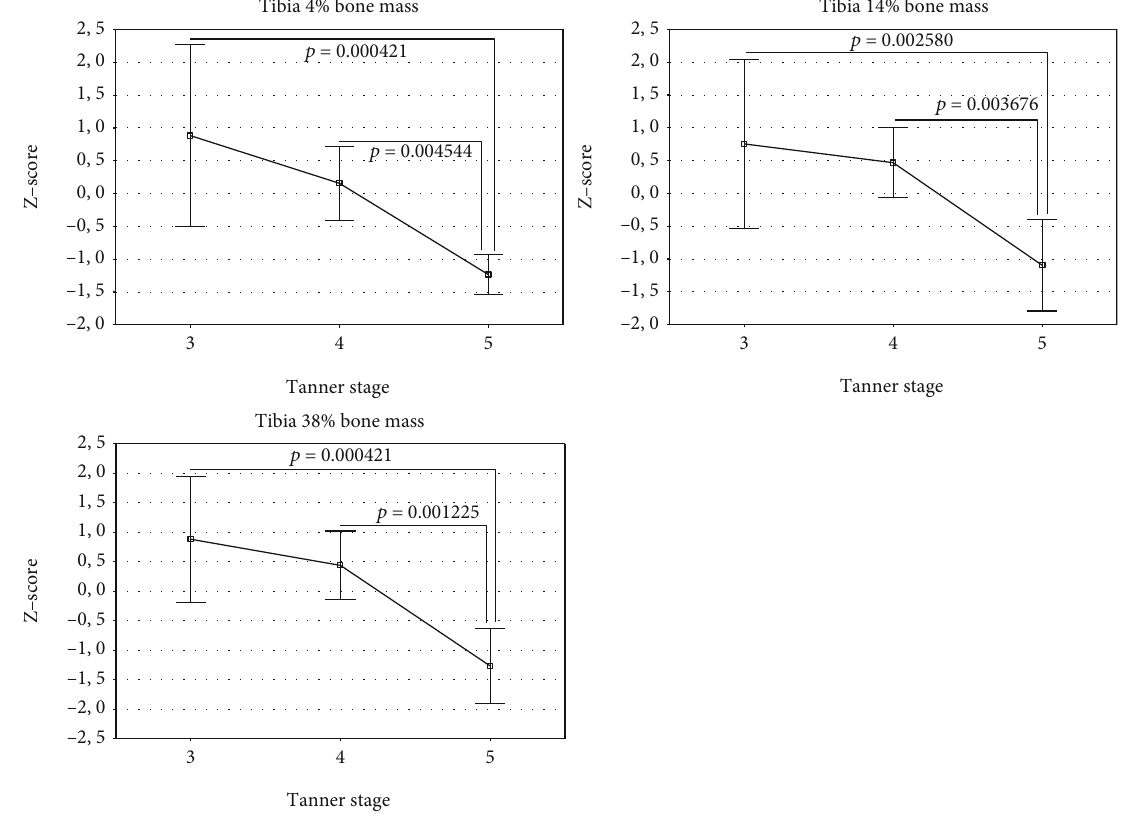
Figure 2: Lower leg Z -scores for bone masses in boys by Tanner stage (mean and 95%